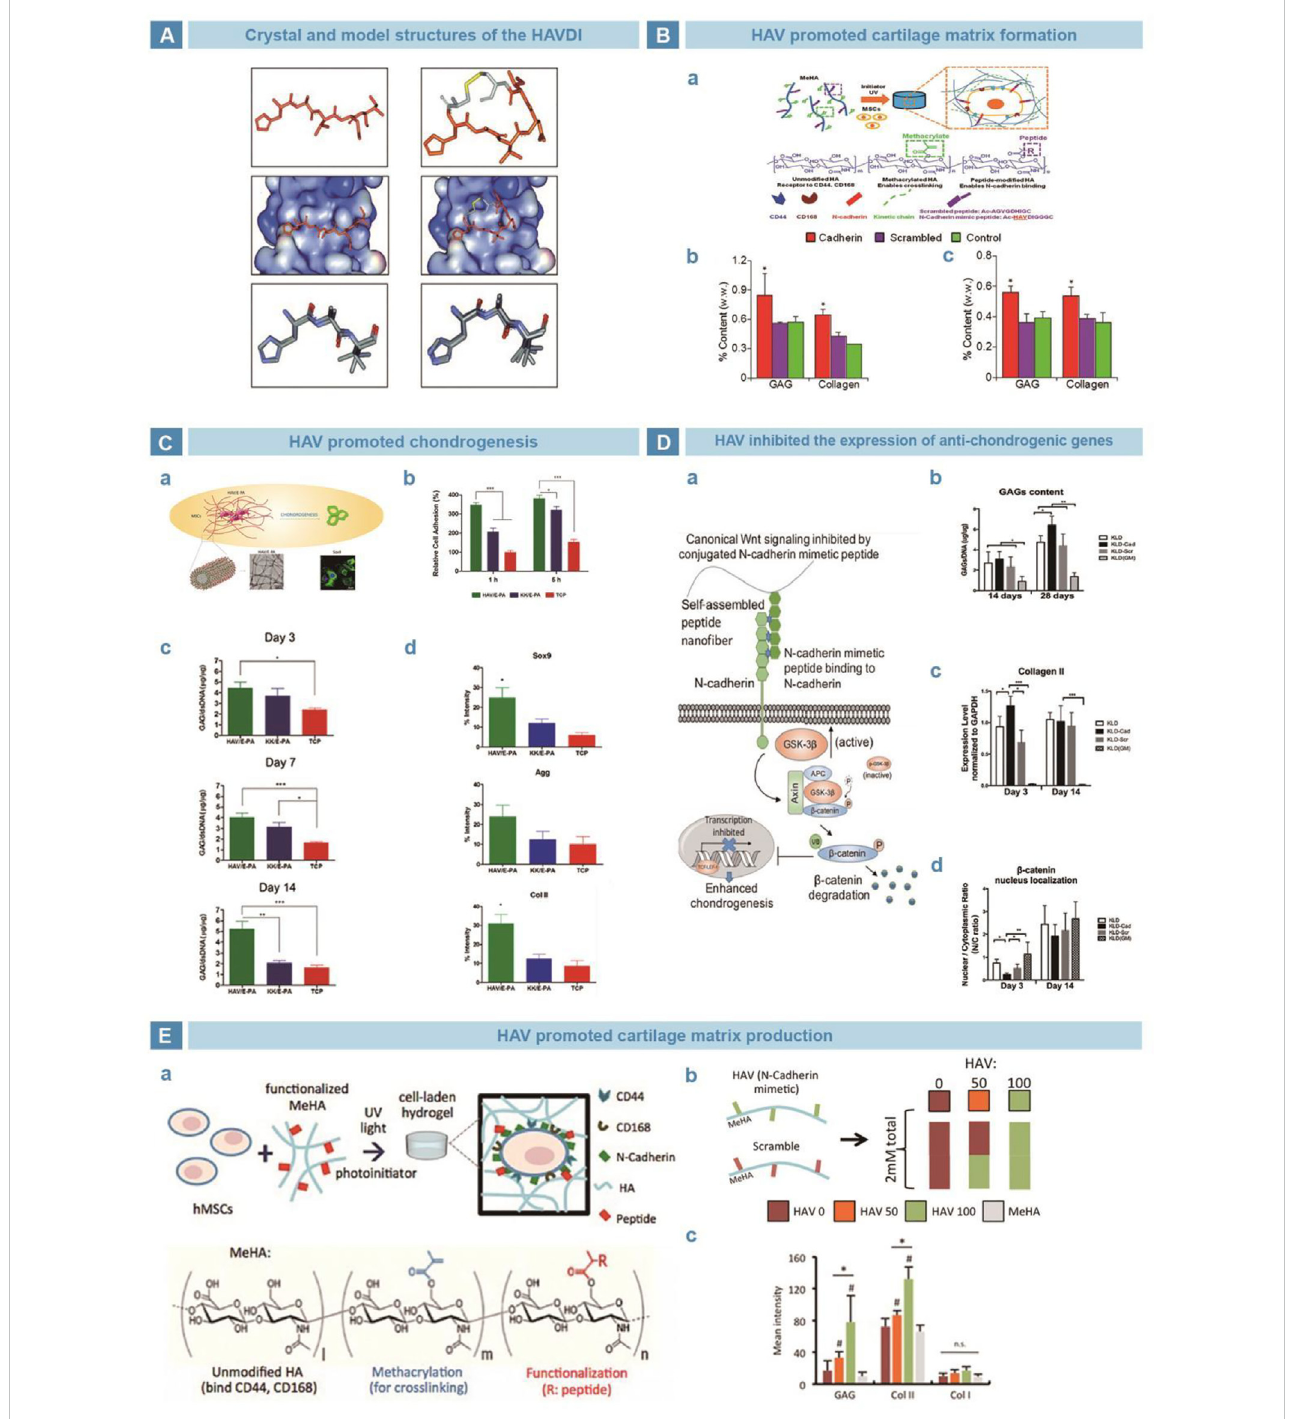
FIGURE 5 N-cadherin mimetic peptide HAV in cartilage engineering. (A) . Crystal structure of HAVDI (Williams et al., 2000). (B) . Tripeptide HAV in chondrogenesis. HAV wasgrafted ontoMeHA hydrogel (A) , and theproductions ofGAGsand collagenwereevaluated invitro (B) and invivo (C) (Bian etal., 2013). (C) . HAV was grafted with E-PA to get nano fi ber network (A) . Cells adhered the HAV/E-PA network well (B) . Cells cultured on the HAV/E-PA scaffold secreted more GAGs (C) ,andshowed higher expressionofchondrogenesis (ErenCimenci etal., 2019). (D) .Self-assembling peptide KLD-HAVDImimicthefunctional domain of N-cadherin (A) . With stimulation of HAVDI, the secretion of GAGs and genetic expression of chondrogenesis were upgraded (B – C) . Meanwhile, the subcellular localization changed (D) (Li et al., 2017a). (E). HAV was grafted to MeHA for crosslinking (A) , and hydrogels of different proportion were prepared (B) . HAV strengthened the expressions of early chondrogenic markers, depending on the dosage strongly (C) (Kwon et al.,